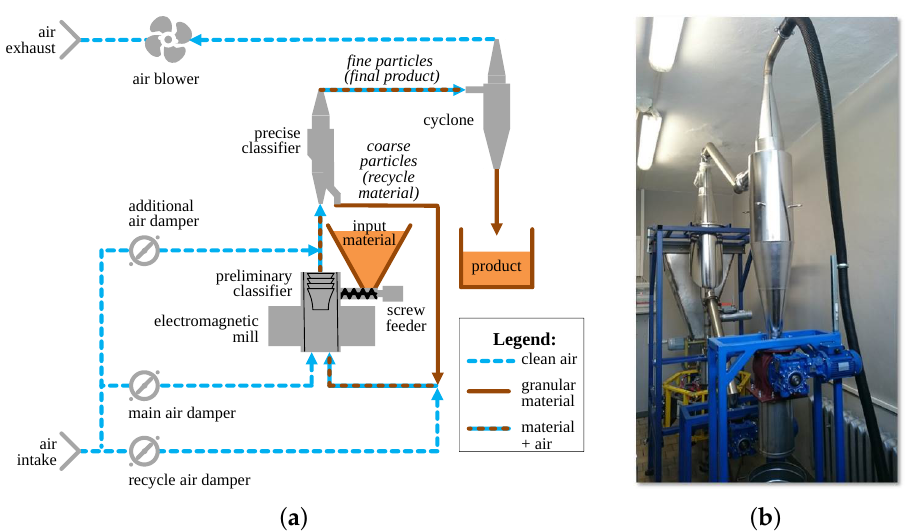
Figure 1. Installation for dry grinding with electromagnetic mill: ( a ) diagram, ( b ) photo–with cyclone in the foreground and precise classifier in the background. Credits: a –by authors, b –by Szymon